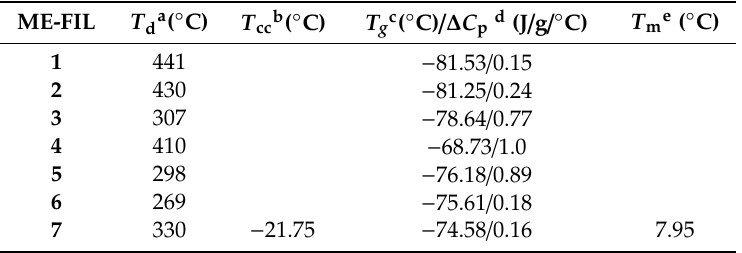
Table 2. Thermal stability and phase behavior of ME-FILs.